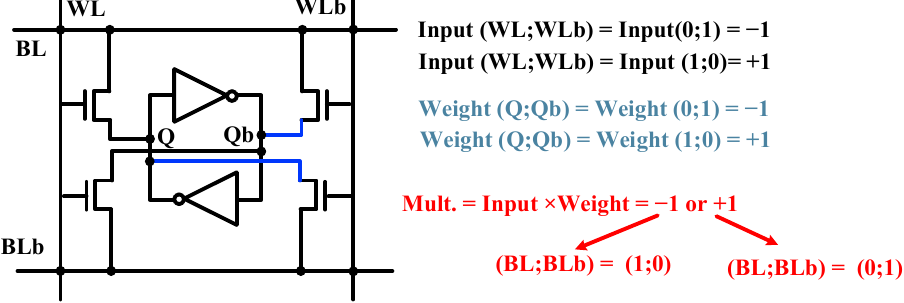
Figure 1. 8T static random-access memory (SRAM) cell design approaches for in-memory X(N)OR logic operation .